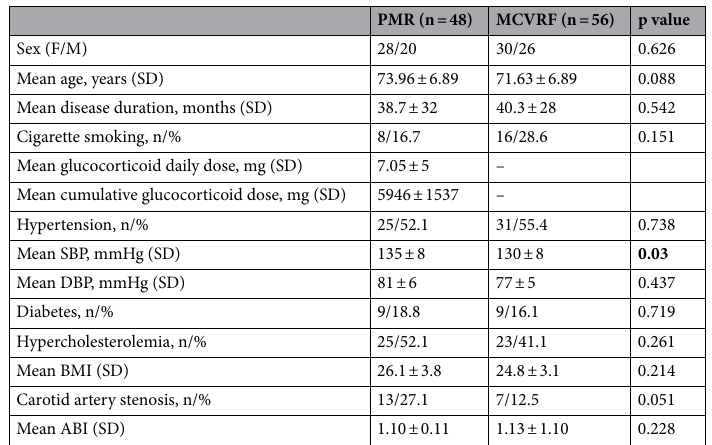
Table 1. Main demographic and clinical data of PMR patients and controls. The p value in bold is the only statistically significant difference PMR polymyalgia rheumatica, MCVRF major cardiovascular risk factors, yrs years, SD standard deviation, SBP systolic blood pressure, DBP diastolic blood pressure, BMI body mass index, ABI ankle-brachial